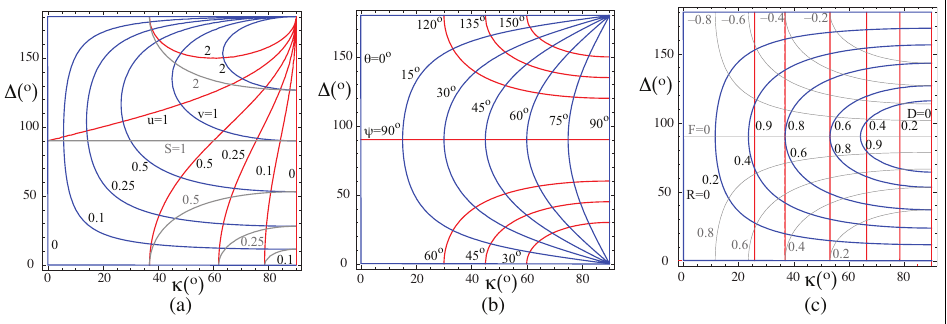
Figure 3. The variation of the parameters ( a ) u , v and S , ( b ) ψ and θ , and ( c ) D , R and F , with κ and ∆ . Summing up, an homogeneous deterministic system can be specified by five parame- ters (neglecting absolute phase), a scalar (the gain, M 00 ), and two unit vectors each with two independent parameters. The unit vectors can be taken as an orientation in Stokes space, described by angles χ , φ or direction cosines l , m , n ; and an orientation in generalized retardation space, described by angles ∆ , κ or ψ , θ , direction cosines F , D , R , or stereographic coordinates u , v . For an inhomogeneous deterministic system, there are seven